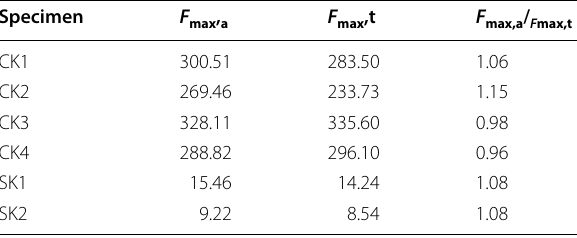
Table 10 Comparison of finite element analysis and experimental results